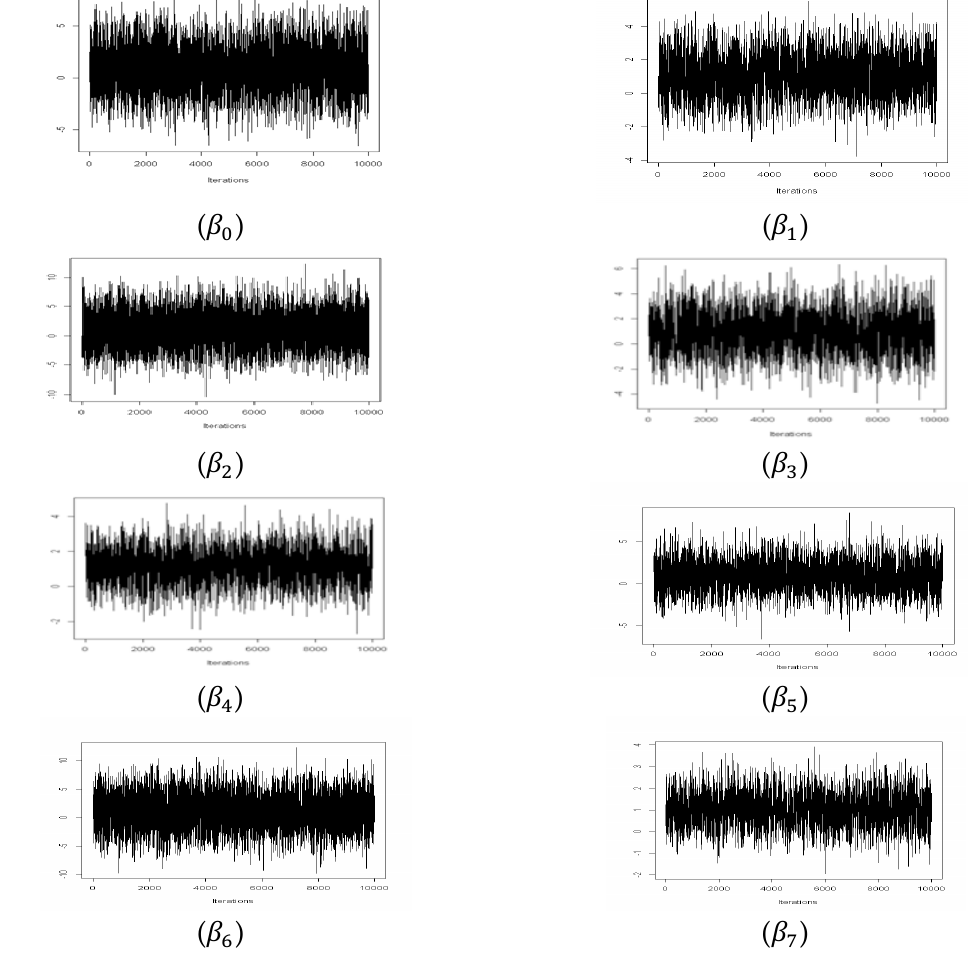
Figure 8. Trace plots of β 0 , . . . , β 7 for the HBLD model using a log-logistic distribution.